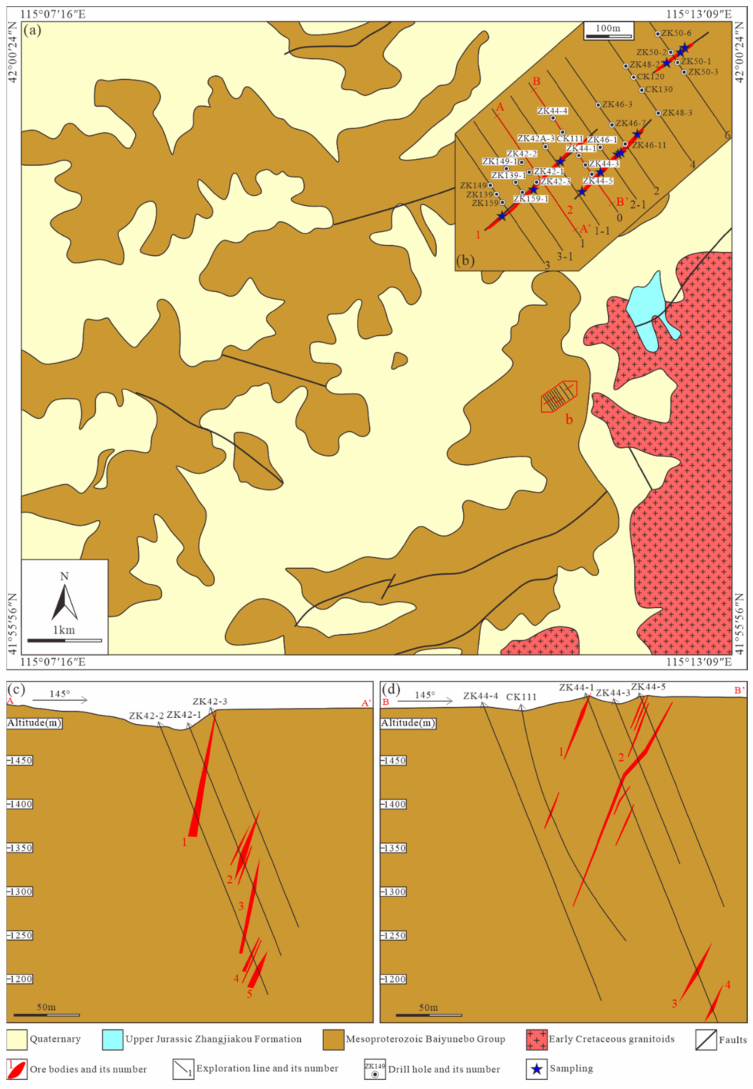
Figure 3. ( a , b ) Sketch geological maps of the Baishitouwa W polymetallic deposit. ( c , d ) Schematic geological cross section of No. 1 and No. 0 exploration line (after